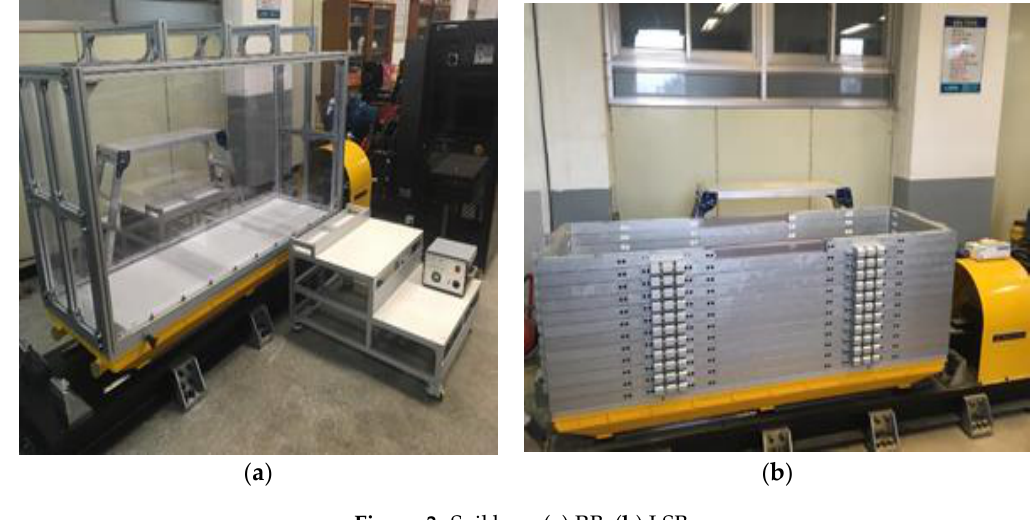
Figure 3. Soil box: ( a ) RB; ( b ) LSB.